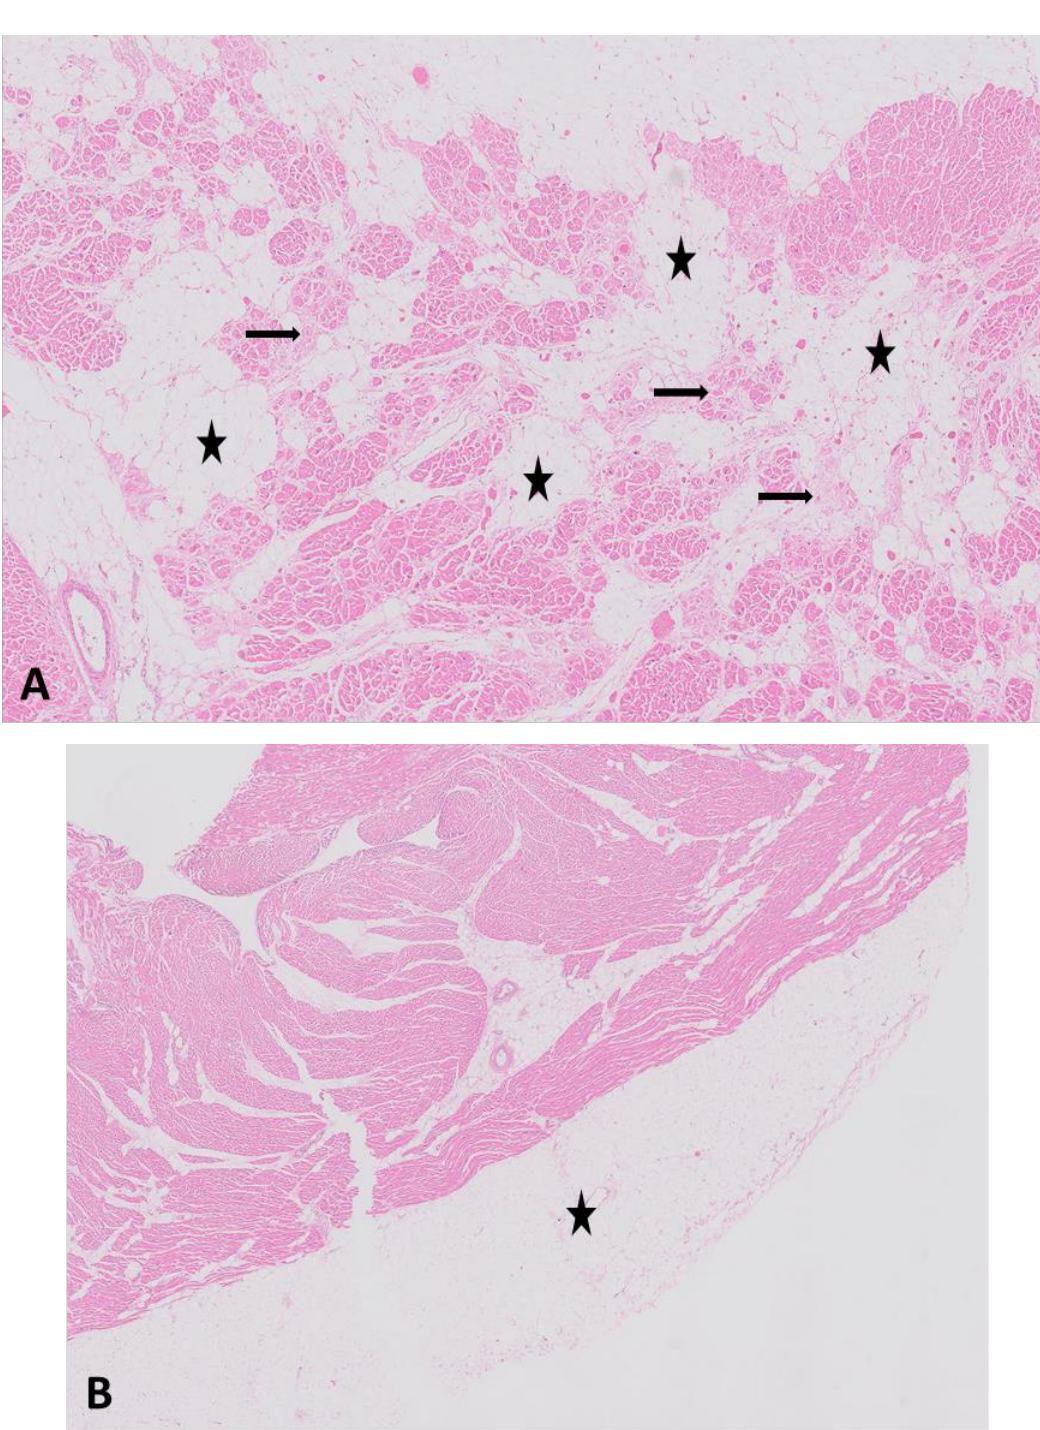
Figure 2. Hematoxylin- and Eosin-stained sections of the left ventricle of the heart ( A ) with extensive fatty and fibrotic changes of the myocardium and the right ventricle of the heart and ( B ) with only epicardial fat. Asterisk indicates fatty tissue. Arrows indicate fibrosis.